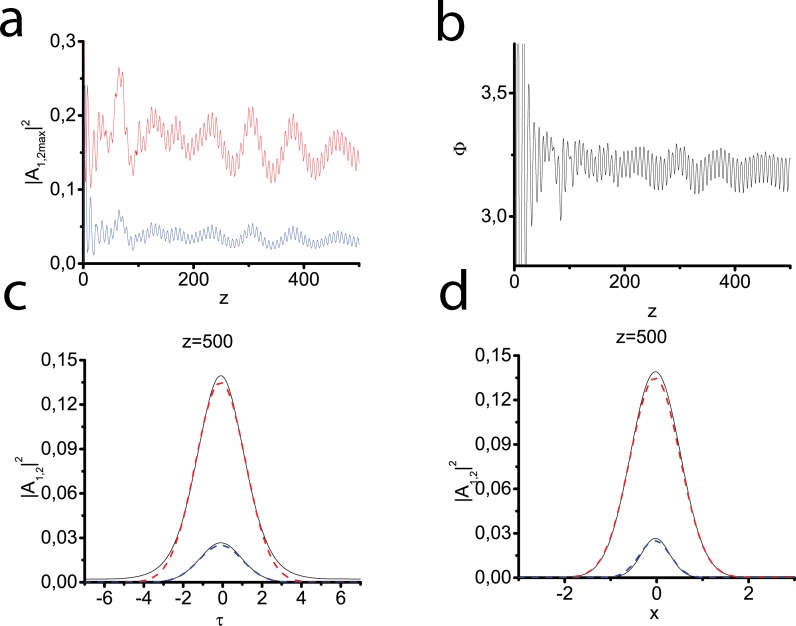
The same as in Fig 4 but waveguide has the Gaussian profile (2.6).